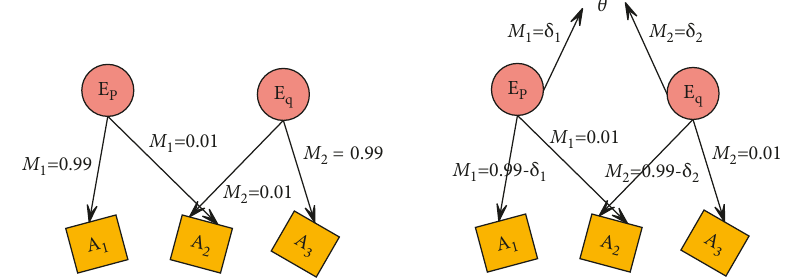
Figure 4: Conflict factor solves Zadeh’s paradox problem.